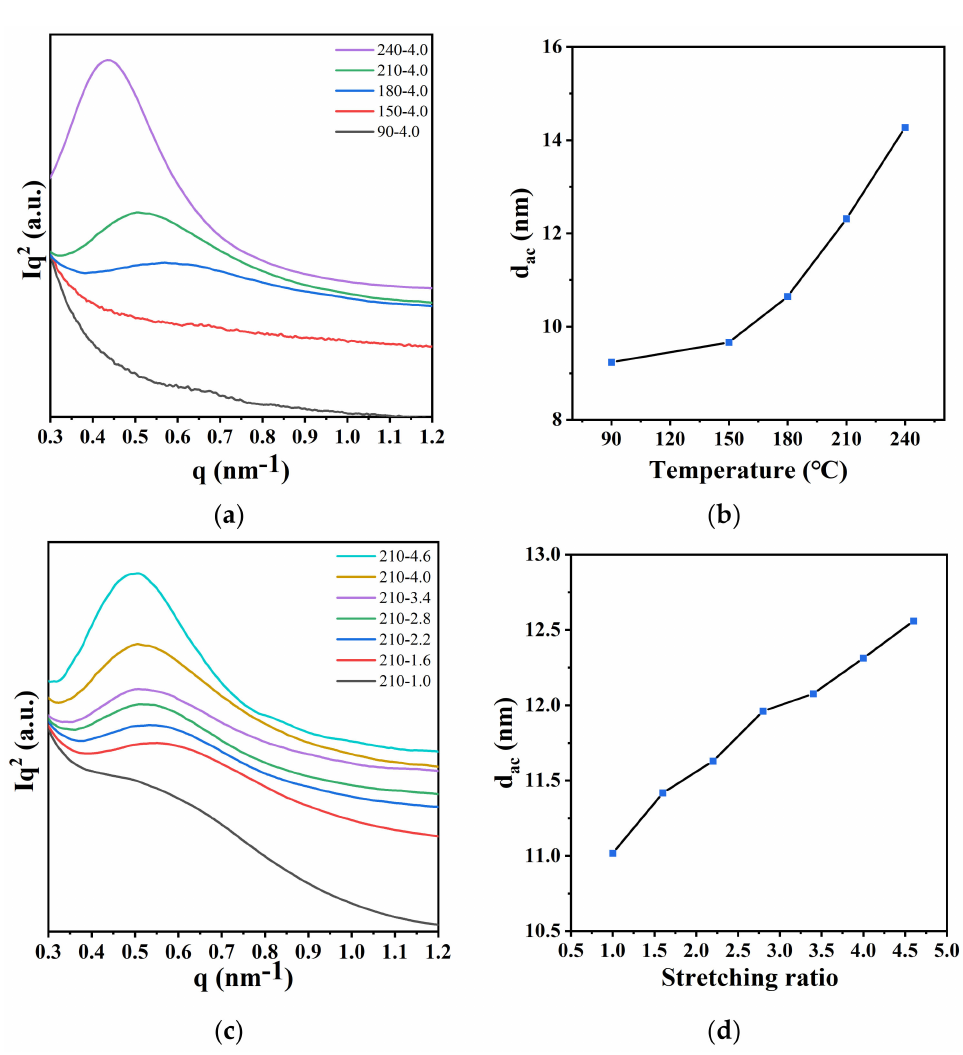
Figure 8. ( a ) 1D-SAXS intensity distribution curves of PA12T films with different stretching tempera- tures; ( b ) relationship between the d ac and stretching temperature; ( c ) 1D-SAXS intensity distribution curves of PA12T samples with different stretching ratios; ( d ) relationship between the d ac and the stretching